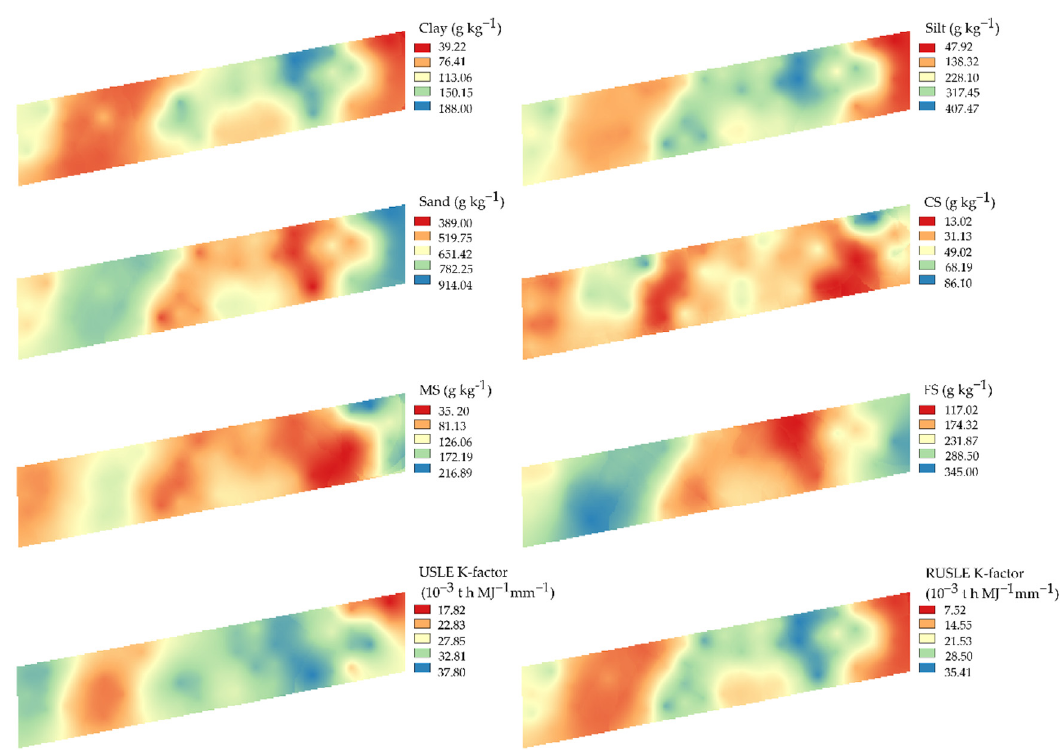
Figure 5. Spatial distribution maps of soil properties that showed spatial